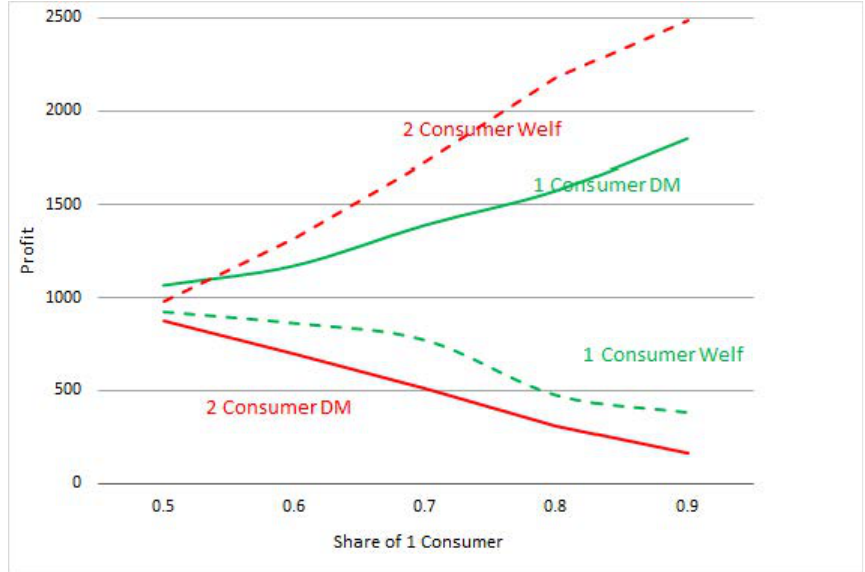
Figure 11. Load of Consumer 1 when its share when its share is 0.6 of the aggregated